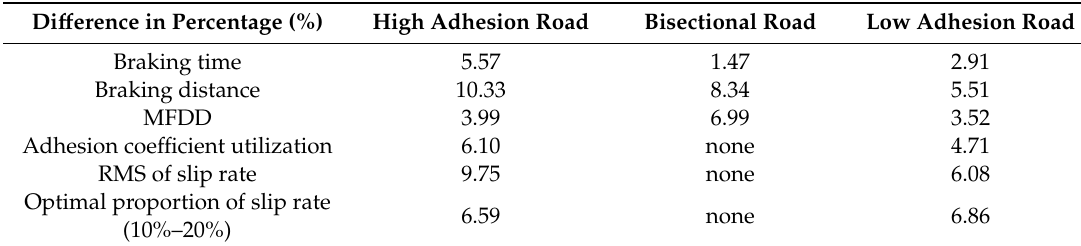
Table 4. Di ff erences between real test and bench